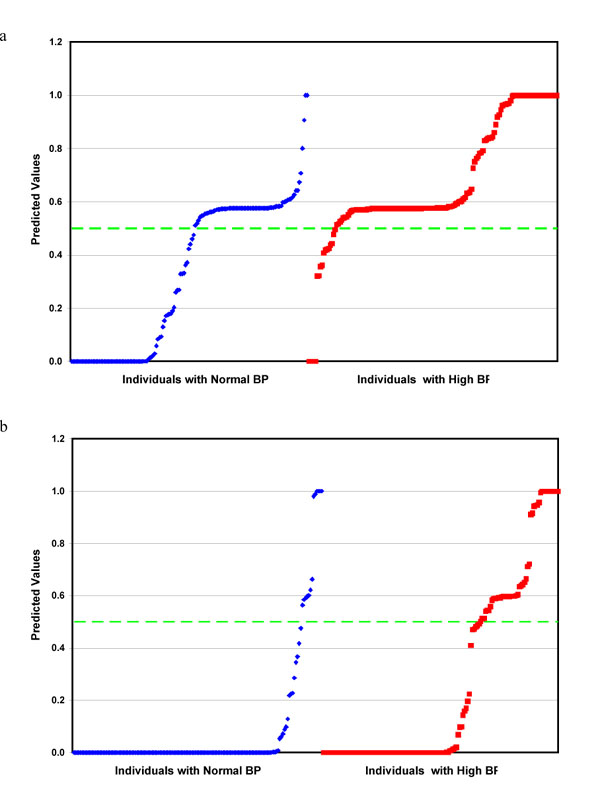
Neural network results: Strategy 2 Cohort 2 a, Results for the training set; b, Results for the validation set. Model with two hidden units. (Blue diamond) Normal BP.,(Red square) High BP; Y < 0.5, normal BP predicted by neural network; Y ≥ 0.5, high BP predicted by neural network.